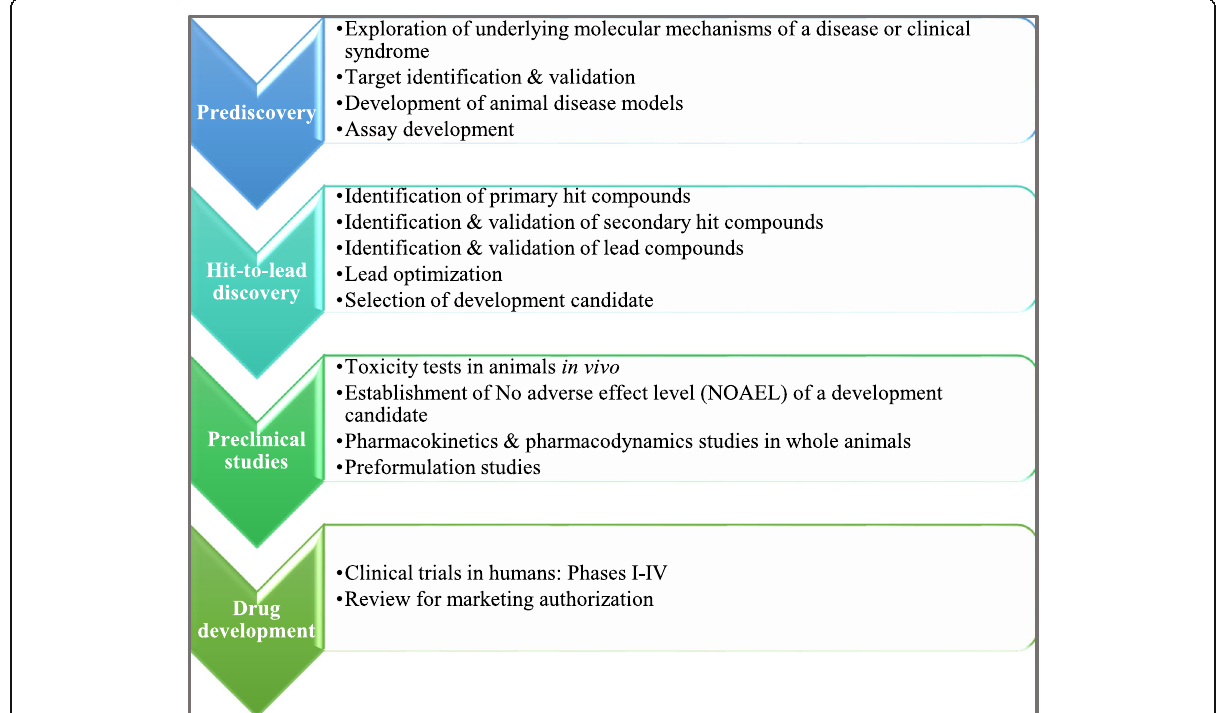
Fig. 1 Generic outline of the drug discovery and development process